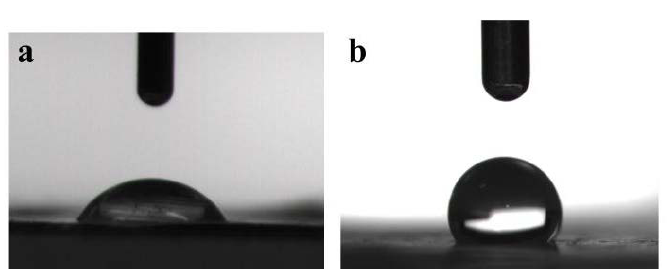
Figure 3. FTIR spectra of samples.